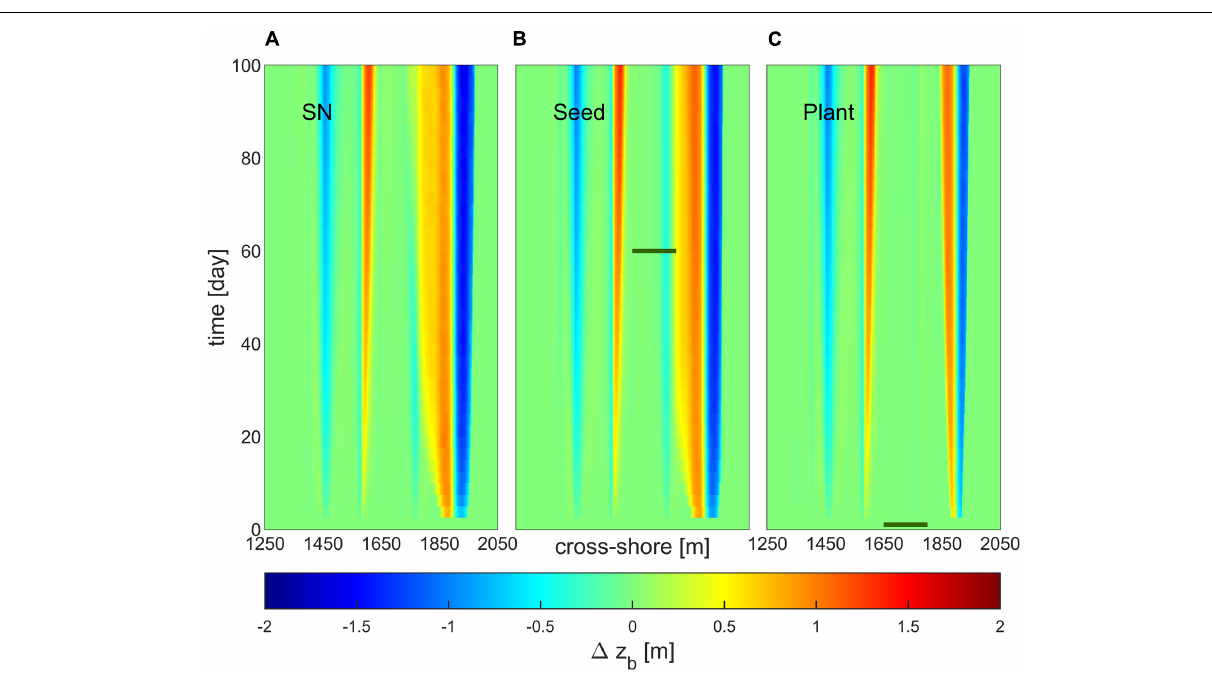
ratio less than 0.2 all over the seagrass meadow and has the least disturbance percentage. For GN1-7, the beach erosion,